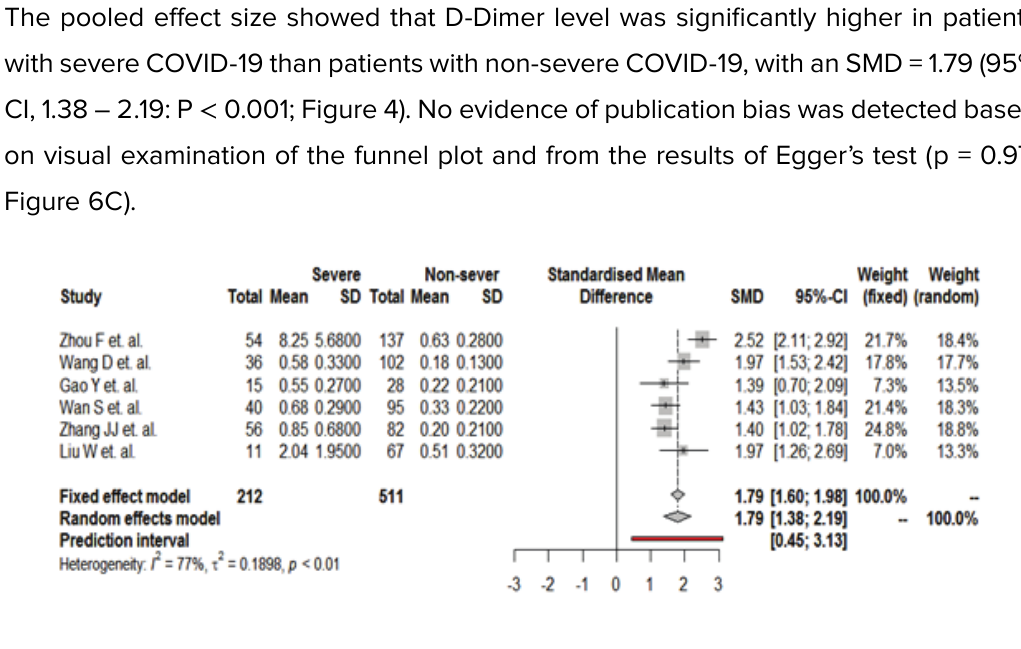
Figure 4: Pooled SMD of D-Dimer estimates between the two groups of patients (severe and non-severe